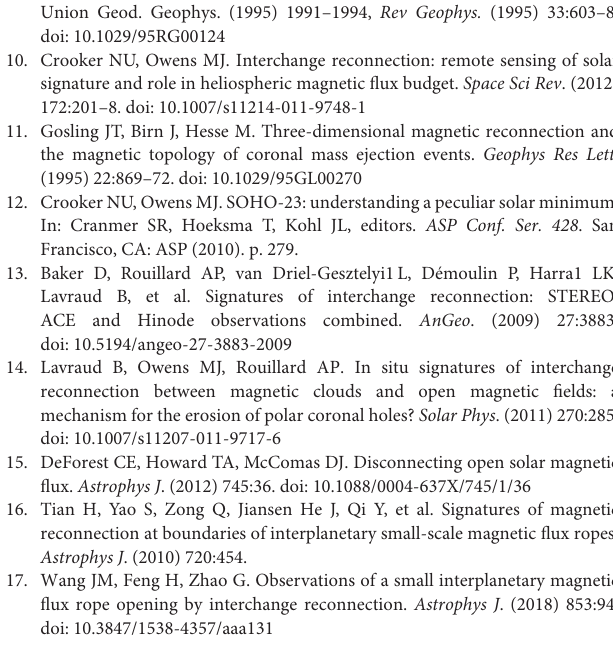
ropes from the Sun. Although we used the terms “interchange reconnection” and “disconnection” here, we were not sure if the reconnection reported here make contribution to the balance of the heliospheric magnetic flux. Since although reconnection was ongoing when the exhaust was detected, the closed magnetic flux produced by the reconnection could not go back to the